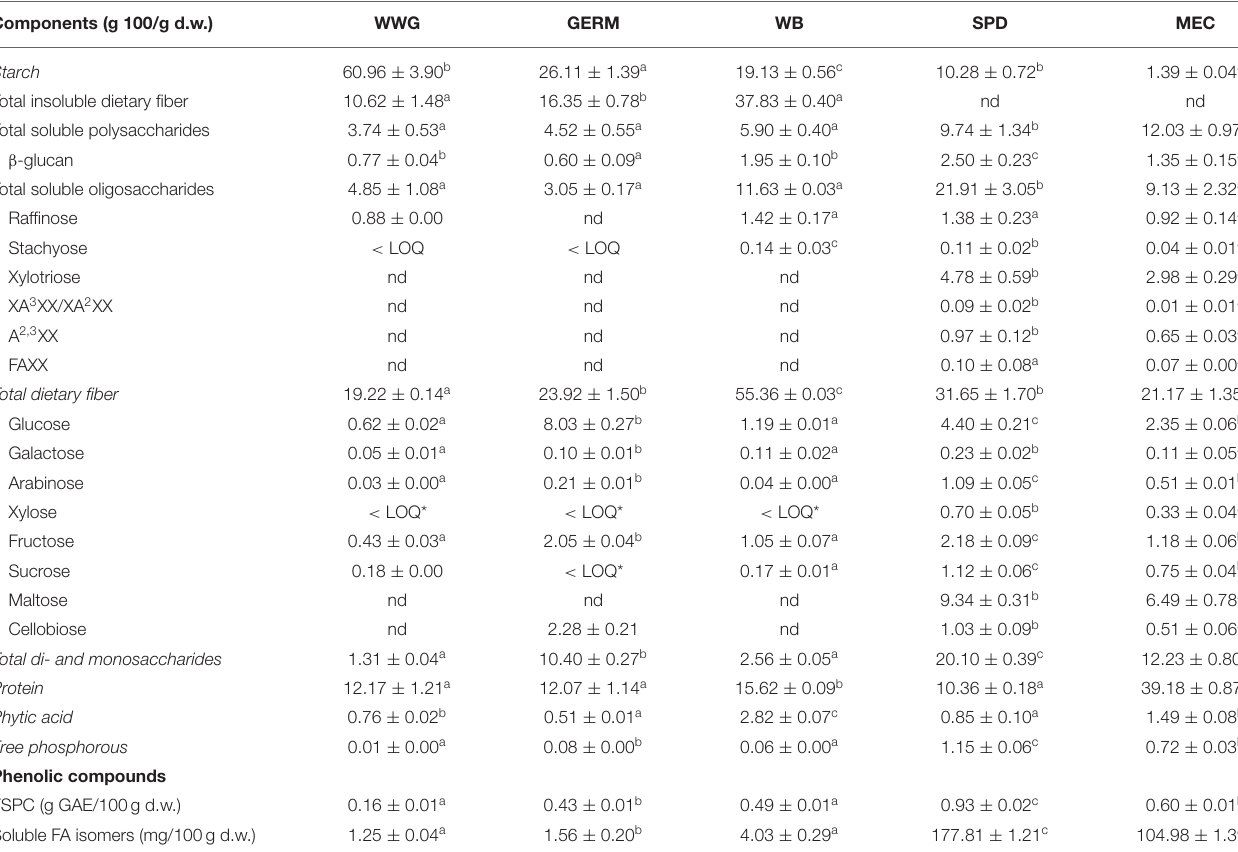
TABLE 1 | Nutritional and nutraceutical composition of whole wheat grain (WWG)- and wheat bran (WB)-derived ingredients. Components (g 100/g